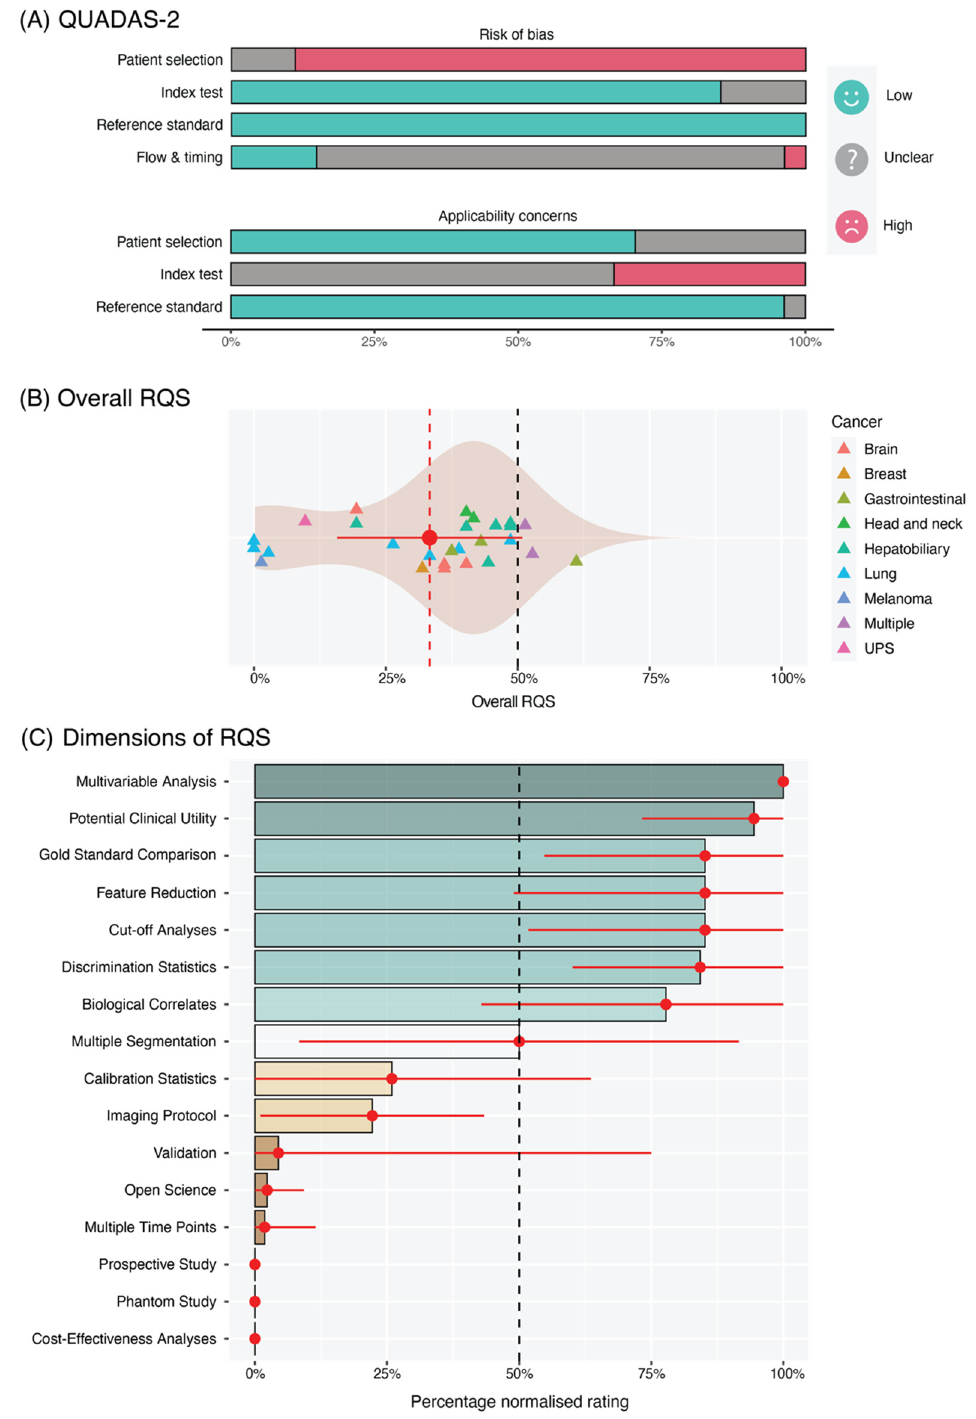
Figure 5. ( A ) Summary of QUADAS-2 risk of bias and applicability concern assessments after arbitration between reviewers. ( B ) Violin plot showing the distribution of the overall RQS scores achieved by reviewed studies. ( C ) Average ratings for each dimension of the RQS, normalised to percentages (0% = minimum possible positive score; 100% = maximum possible positive score).